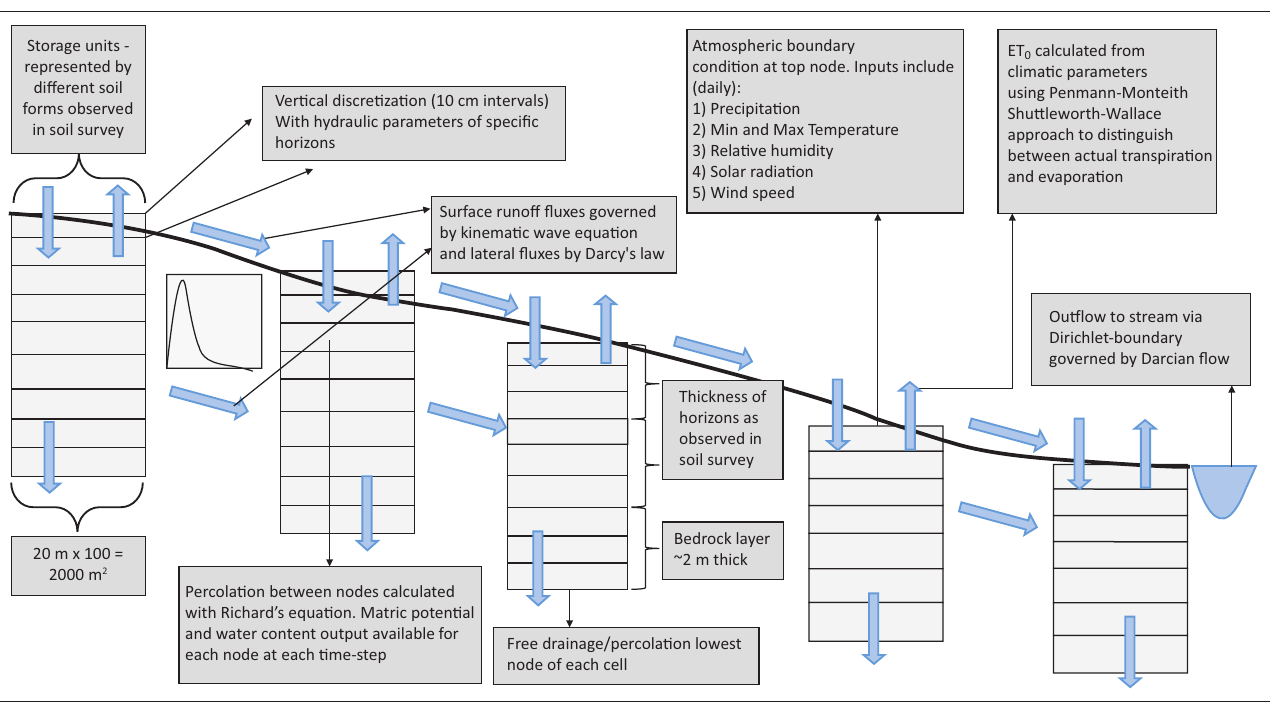
FIGURE 2: Hillslope configuration and hydrological parameters/processes employed in catchment modelling framework for the